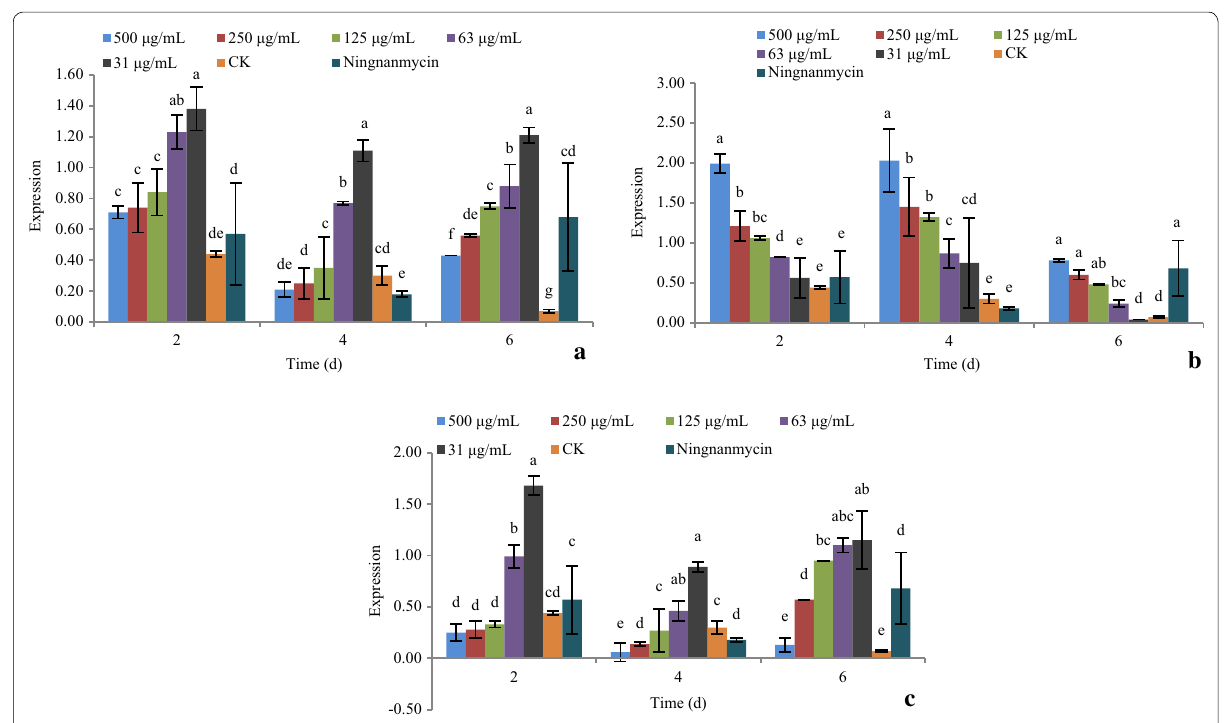
Fig. 6 The effect of active compounds 1 , 5 , and 9 on the expression of gene XTH . a Compound 1 ; b Compound 5 ; c Compound